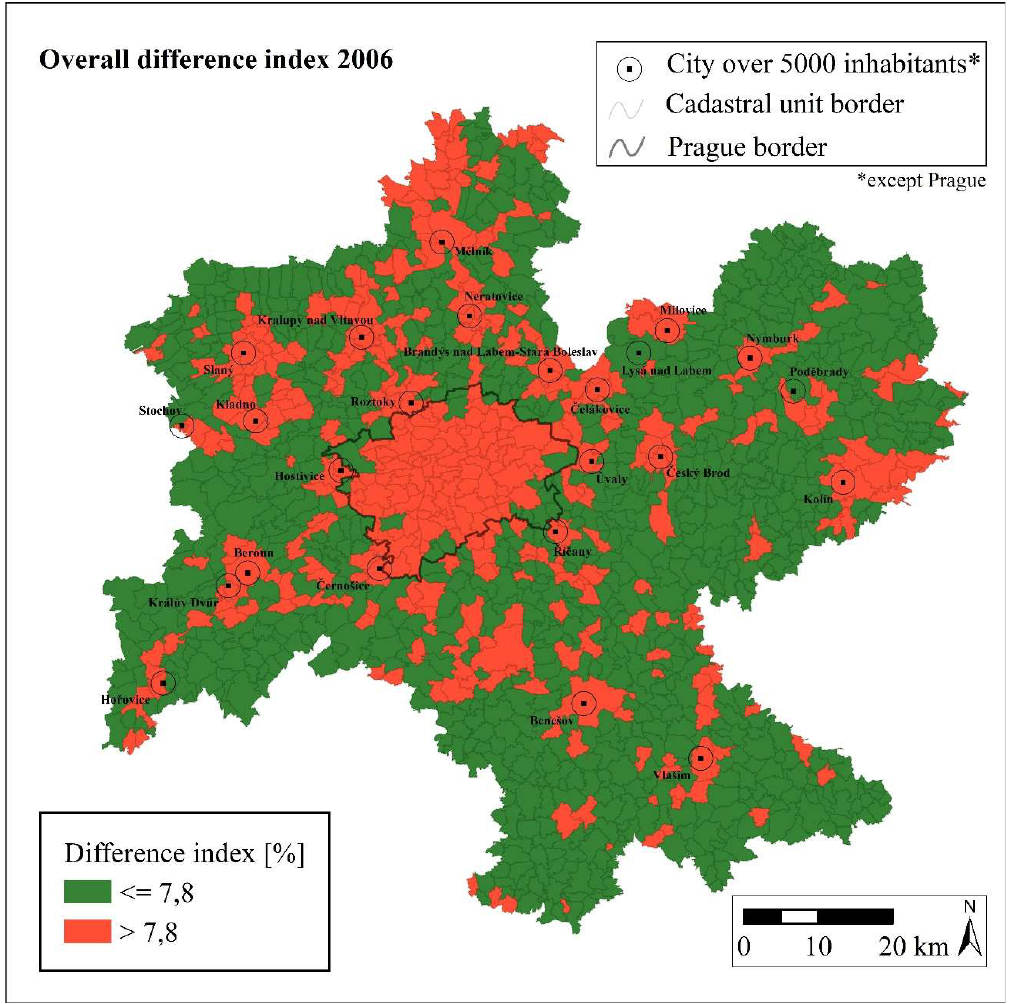
Figure 6. Territorial di ff erences of the DI, 2006. Source: [31,33].